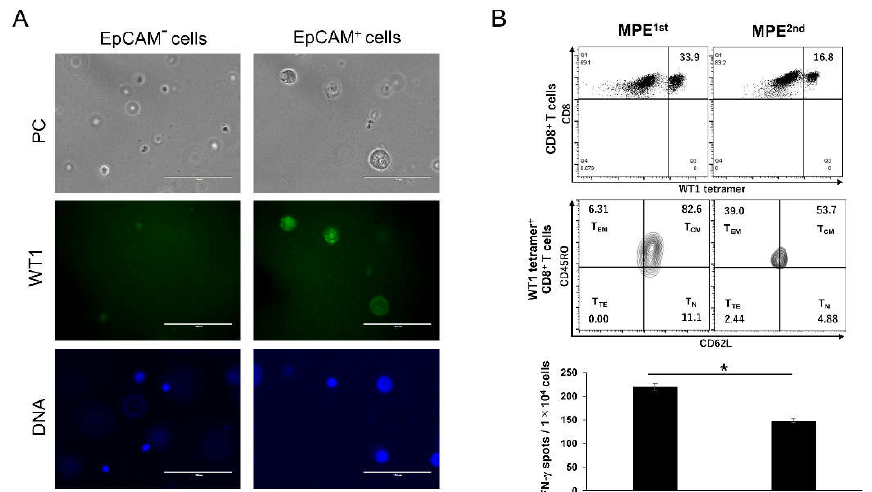
Figure 2. WT1 expression on EpCAM + cancer cells and detection of memory subsets of WT1-CTLs in MPE samples. ( A ) Expression of WT1 on EpCAM positive or negative cells sorted from whole cells in MPE 1st . PC, phase contrast; WT1 cells were stained with anti-WT1 antibody, followed by Alexa Fluor ® Plus 488 secondary antibody; DNA, DAPI staining. The white bar indicates 100 µ m. ( B ) The ratio of WT-CTLs is defined as WT1 tetramer + CD8 + T cells to MPE samples 1st or MPE 2nd (upper panel). The memory subsets of WT1-CTLs during disease progression (middle panel). CD62L + CD45RO + : central memory T cells (T CM ); CD62L + CD45RO – : naïve T cells (T N ); CD62L – CD45RO + : effector memory T cells (T EM ), CD62L – CD45RO – : terminal effector T cells (T TE ). The function of WT1-CTLs in MPE was evaluated by ELISpot assay for IFN- γ secretion under WT1 235 peptide stimulation (lower panel). The mean number of spots of WT1 235 peptide-specific was shown. The error bar indicated the mean and standard deviation. Unpaired t-test, * p < 0.05.